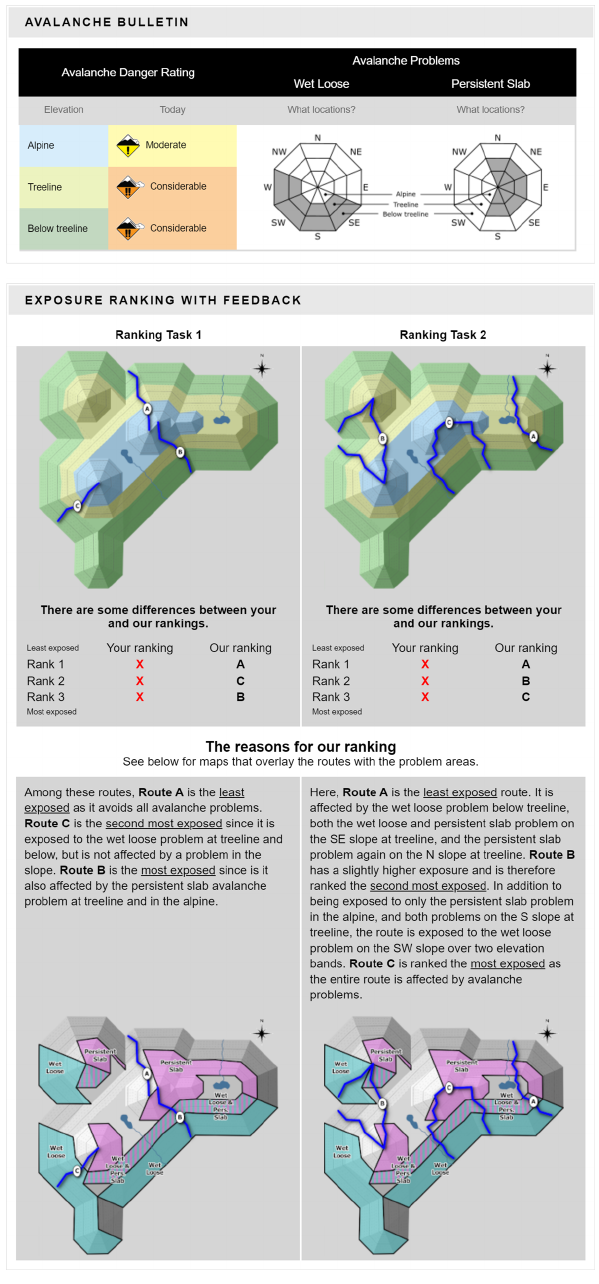
Figure A6. Screenshot of scenario 6 (ID 9) with avalanche bulletin information, route options, ranking solutions, and explanations.